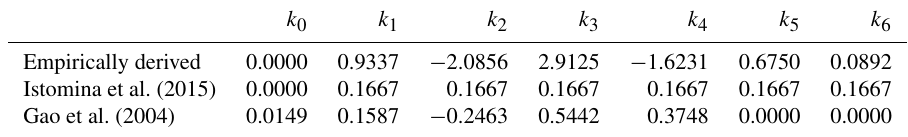
Table 2. Coefficients k i in Eq. (1) to calculate MERIS broadband albedo from spectral albedo at the six wavelengths 400, 500, 600, 700, 800, and 900nm (for Gao et al., 2004, from the narrowband albedo at channels with the center wavelengths 490, 560, 665, and 865nm). k 0